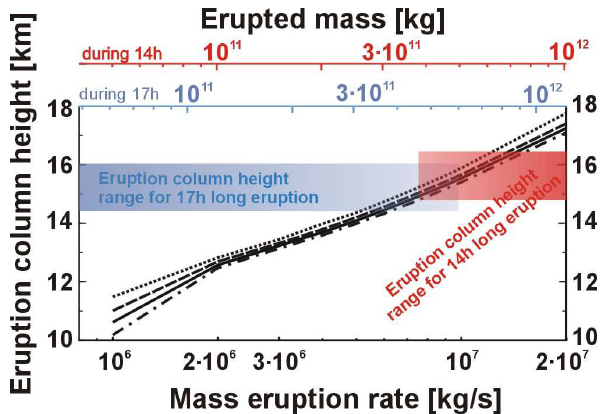
Fig. 7. Model calculation showing the rise height of the eruption cloud during a volcanic eruption as a function of the mass eruption rate. The solid line is for a gas content of 3 wt%, an initial velocity of 300 m s -1 . The dotted line is for 3 wt% and 100 m s -1 initial velocity, the dash dotted line is for 2 wt% and 300 m s -1 , and finally the dashed line is for 4 wt% and 300 m s -1 . The top two axes show the erupted mass in case the eruption lasted for 14 or 17 hours.